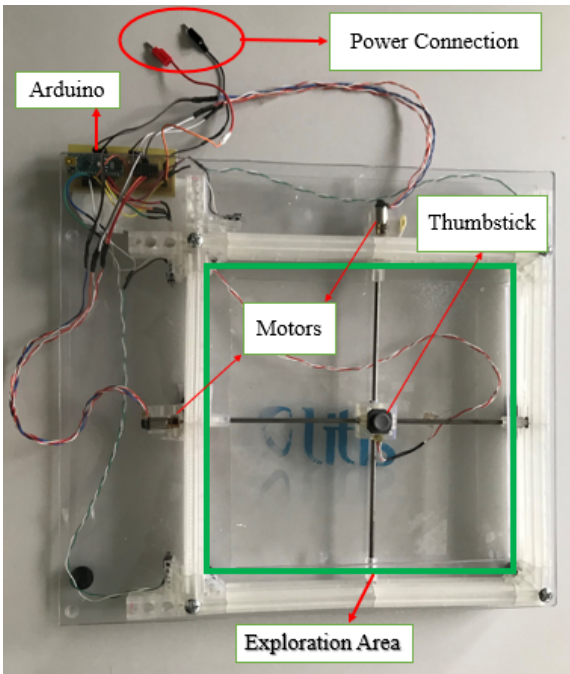
Figure 5. F2T current